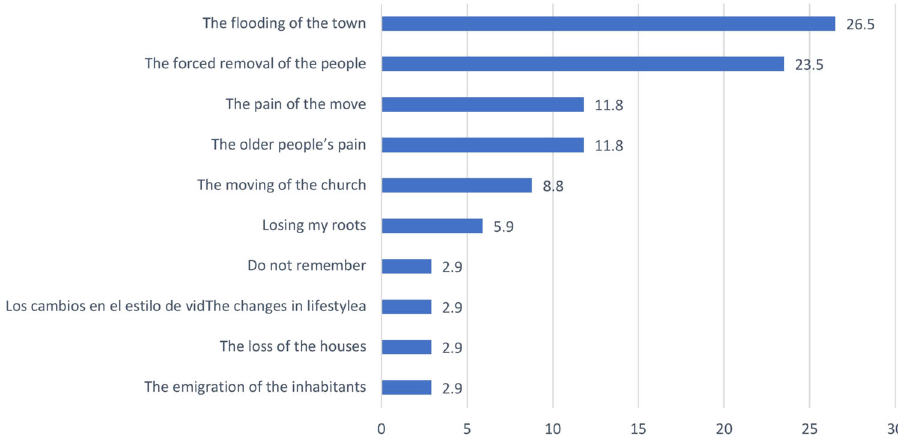
Fig. 8 Local community. Inhabitants of Old Portomarín. What memory has had the biggest impact on you?